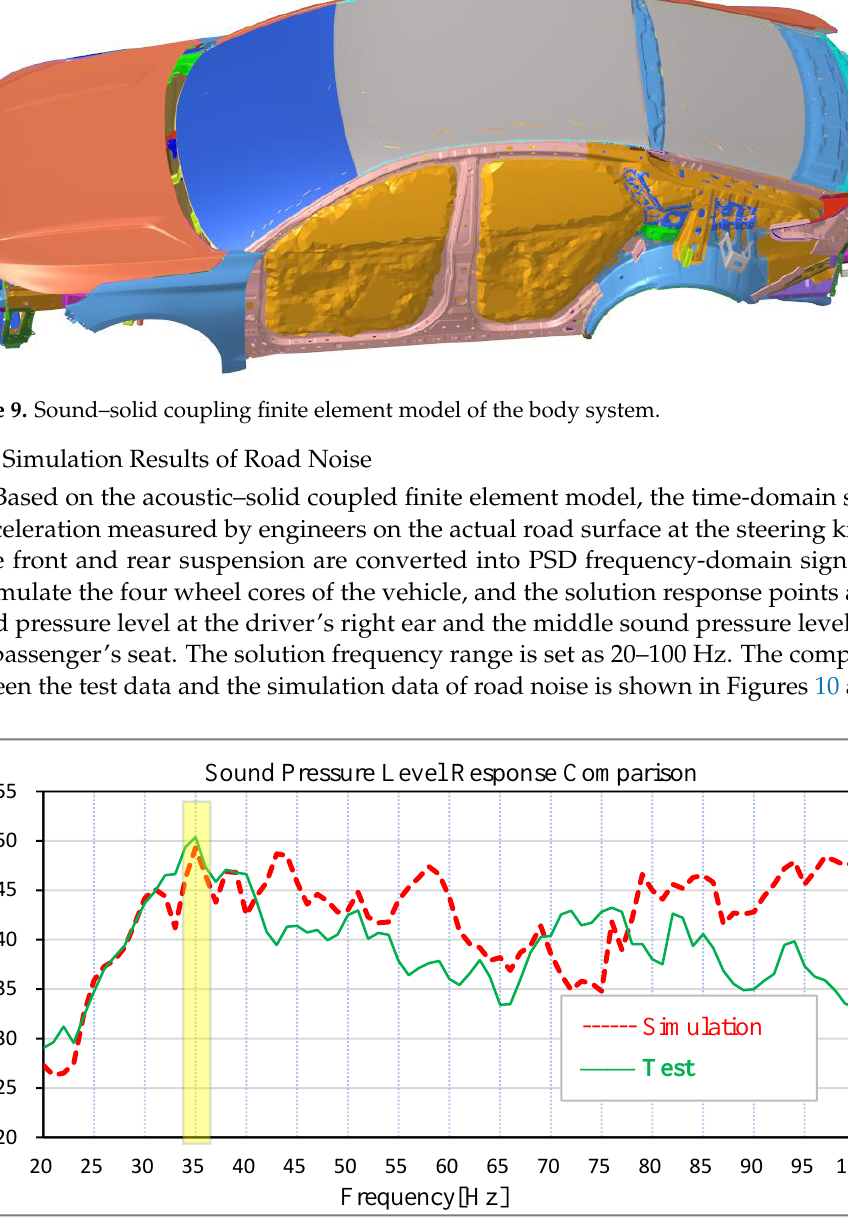
Figure 10. Comparison of test results and simulation results of driver’s right ear noise.